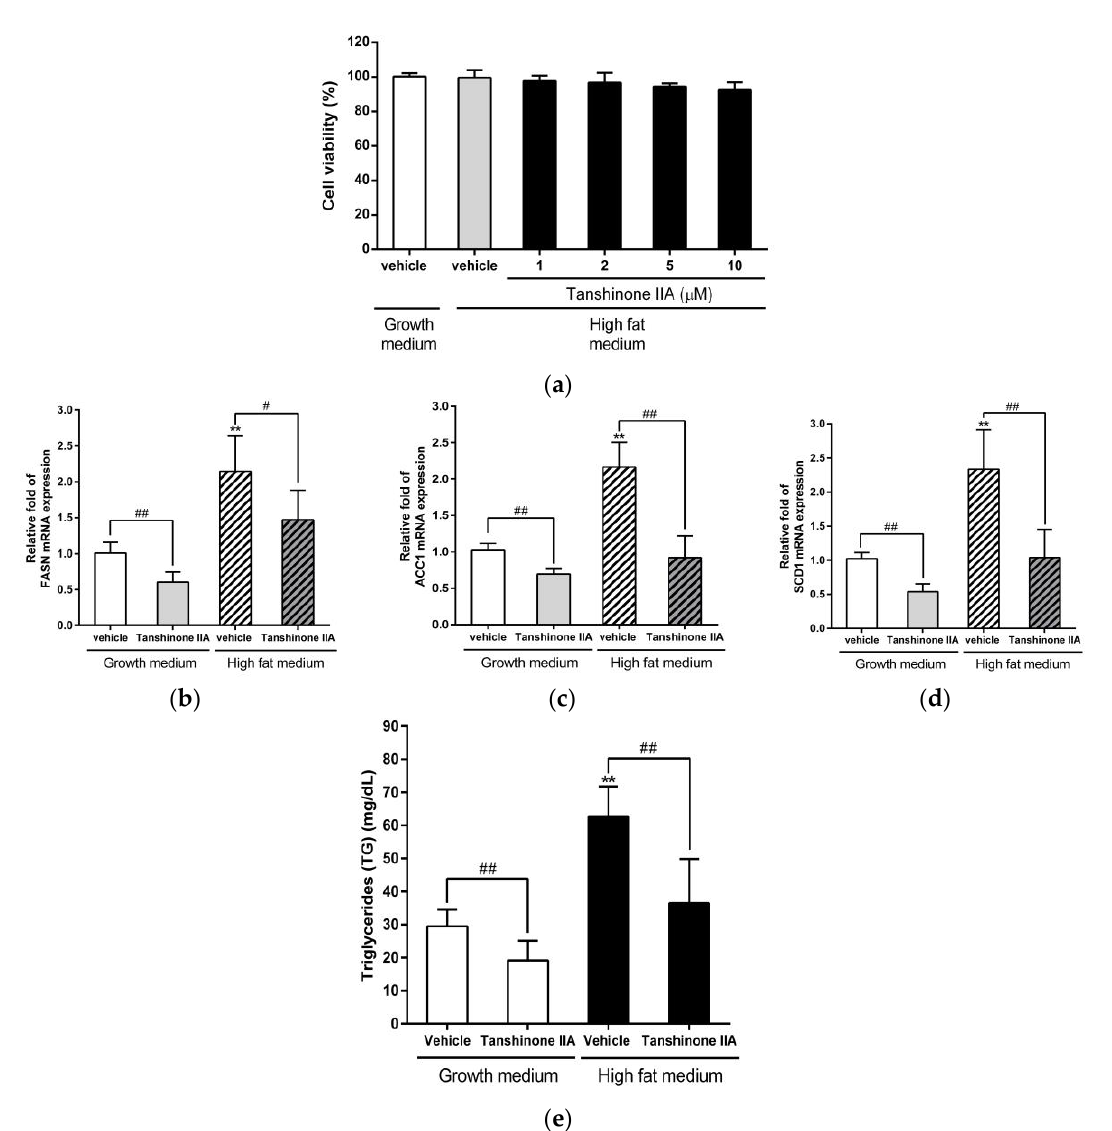
Figure 5. Effects of tanshinone IIA on the fatty-acid-induced lipogenesis and TG accumulation in HepG2 cells. HepG2 cells were treated with vehicle (0.1% DMSO) or tanshinone IIA (1 – 10 μM) in growth medium ( DMEM with 10% FBS and 1xNEAA), and after 20 h, the medium was replaced with high-fat medium containing the indicated compounds (vehicle or tanshinone IIA). ( a ) Cell viability was measured using an MTT assay. The mRNA expression of ( b ) FASN, ( c ) ACC1, and ( d ) SCD1 was measured by RT-qPCR analysis. The data represent the mean ± SD of three independent experiments. # p < 0.05 and ## p < 0.01 indicate significant differences compared to the vehicle-treated cells. ( e ) Intracellular triglyceride (TG) levels of vehicle- or tanshinone-IIA-treated HepG2 cells were measured from three independent replicates, and the data represent the mean ± SD. ** p < 0.01 indicates significant differences compared to the vehicle-treated cells incubated with growth medium. ## p < 0.01 indicate significant differences compared to the tanshinone IIA-untreated